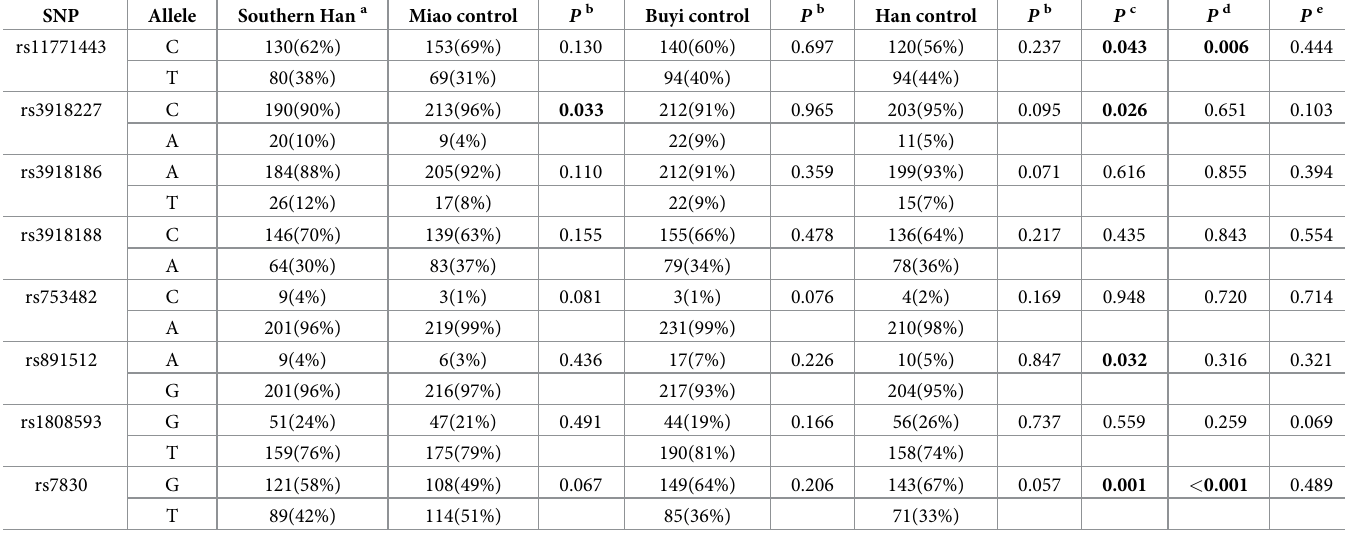
Table 7. Comparison of allele frequencies between Guizhou populations and Southern Han